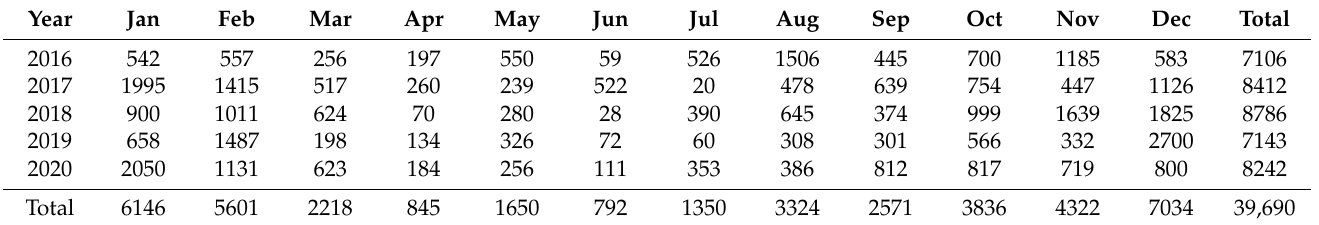
Table 1. Sample crash (filtered by injury-only) data involving adverse conditions. In this case, fog and related weather.